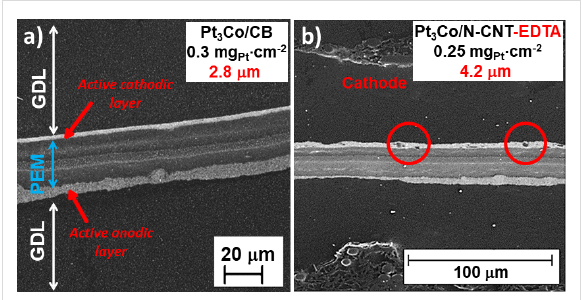
Figure 12: SEM micrographs of MEA sections prepared with Pt 3 Co/CB at 0.3 mg Pt ·cm − 2 and Pt 3 Co/CNT-N at 0.25 mg Pt ·cm − 2 .